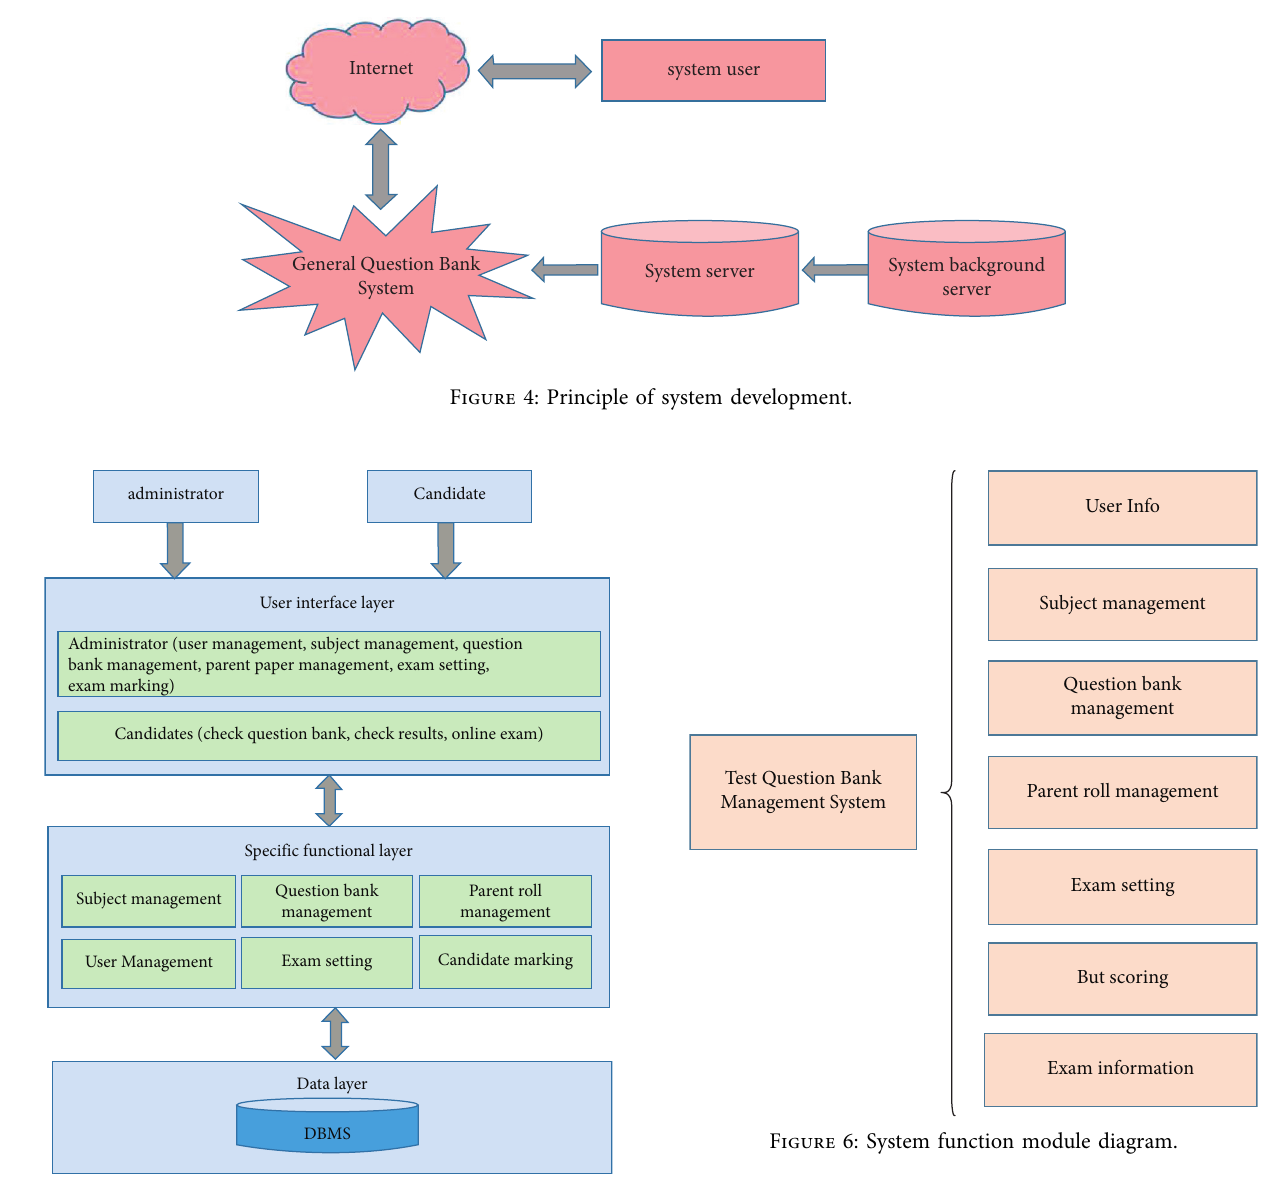
Figure 5: System structure division diagram.